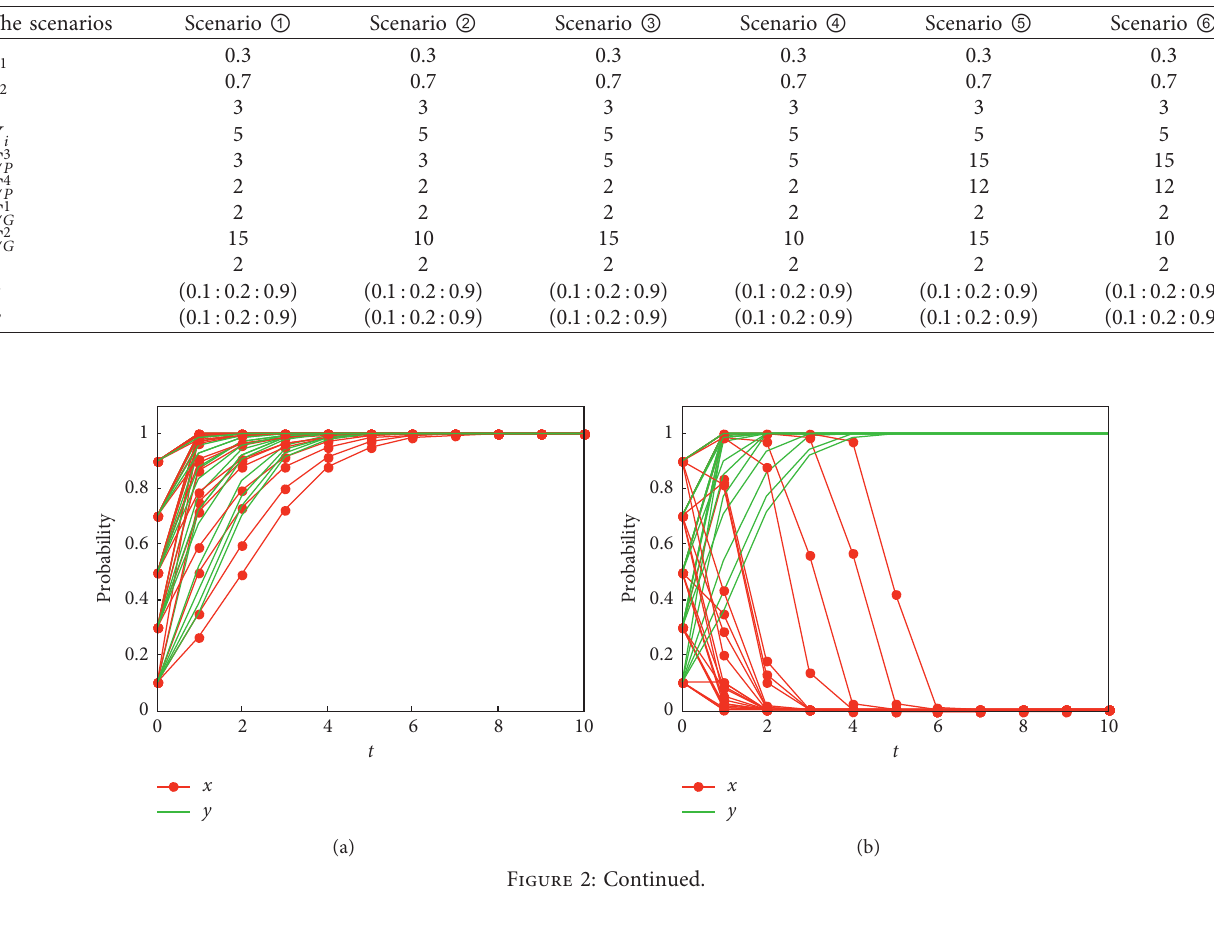
Table 7: The assumed values of the parameters under the six scenarios.